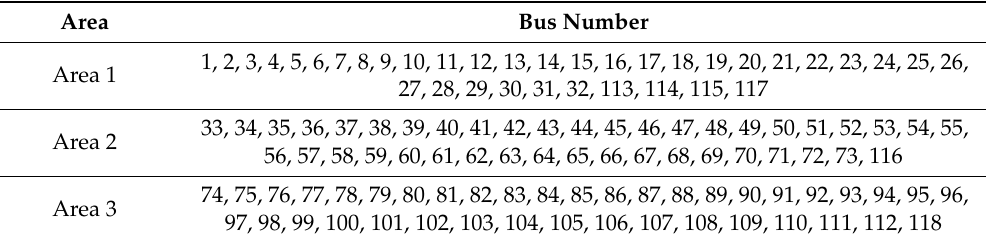
Table 8. Buses in each area (modified IEEE 118-bus test system).